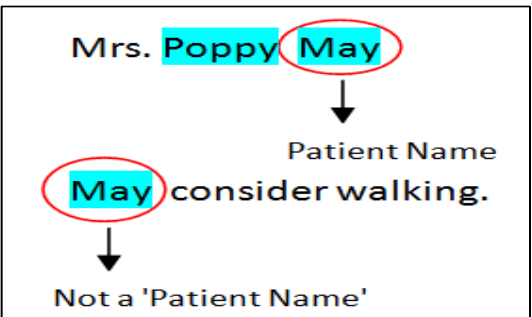
FIG. 2: OUTPUT OF DICTIONARY